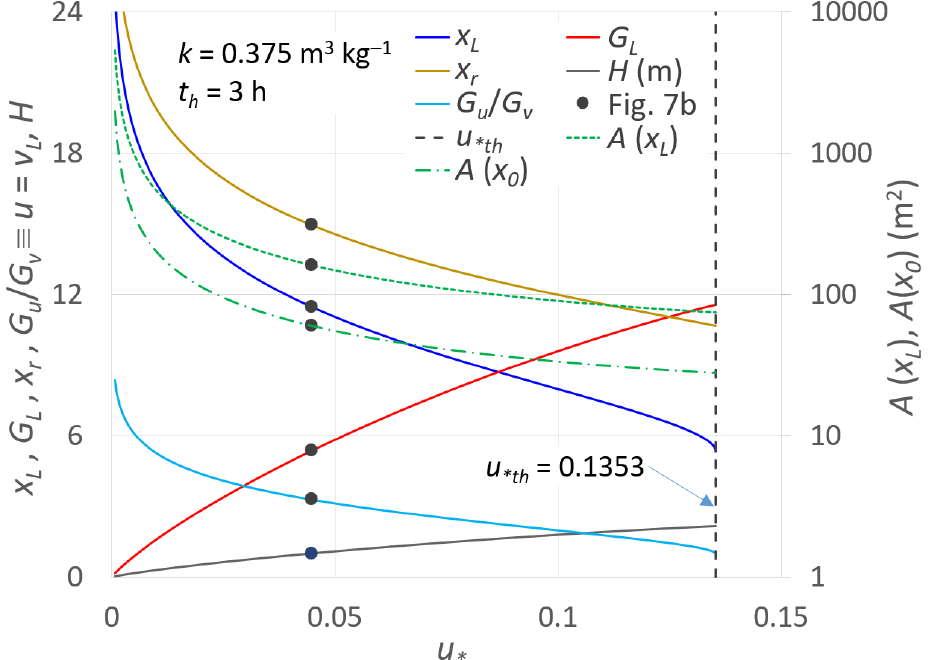
Figure 8. For k = 0.375 m 3 kg − 1 and t h = 3 h, relationship between the dimensional parameters: limiting SS concentration, x L ; the corresponding solid flux G L ; the SS concentration of the recycle flow rate, x r ; the G u / G v ratio; the clarifier height, H ; and the clarifier surface area, A (secondary axis), for x = x L and x = x 0 , A ( x L ) and A ( x 0 ), respectively, versus u * . The dots refer to the example application of Figure 7b. The dashed line delimits the real x L solutions domain ( u *th = 0.1353).